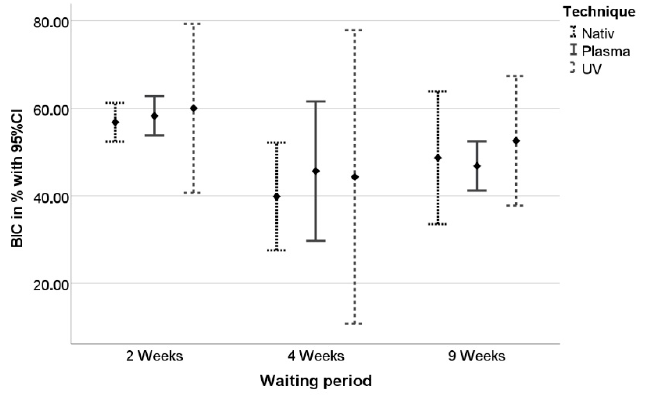
Figure 9. Microscope images after healing and histomorphometrical preparation. Upper row after 2 weeks of healing (1. Control, 2. CAP, 3. UV-light), middle row after 4 weeks of healing (4. Control, 5. CAP, 6. UV-light), lower row after 9 weeks of healing (7. Control, 8. CAP, 9. UV-light).